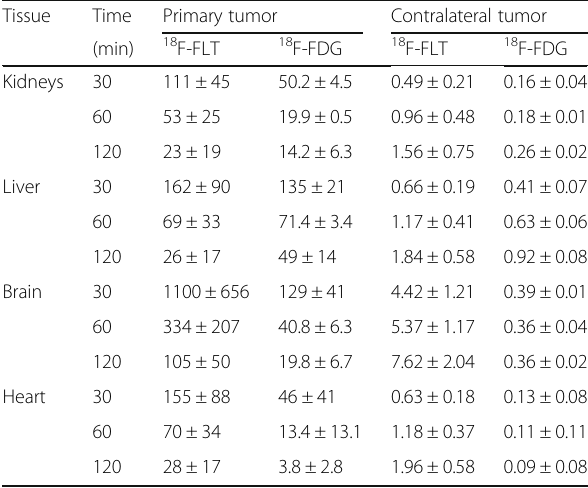
Table 3 Tumor-to-tissue ratios of 18 F-FLT and 18 F-FDG at three different times post injection after i.t. infusion of 5 MBq into a single tumor Tissue